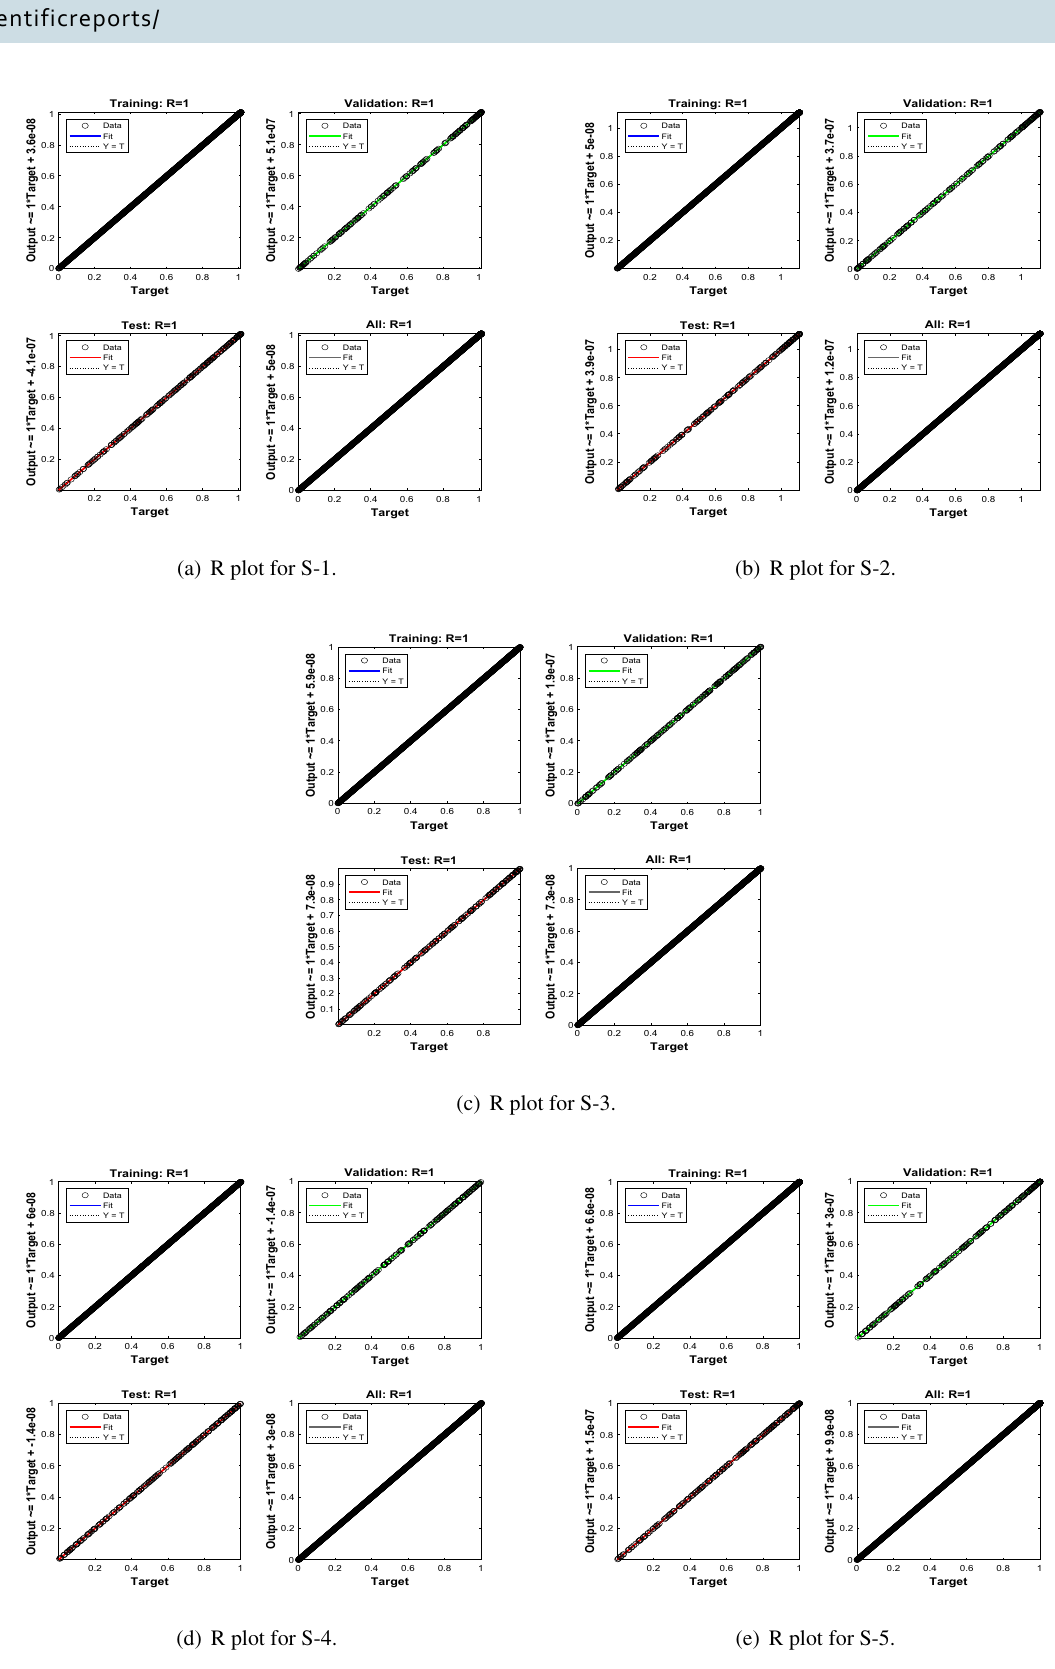
Figure 19. Regression (R) views of LMA-TNN results for Case 4 in Reynolds